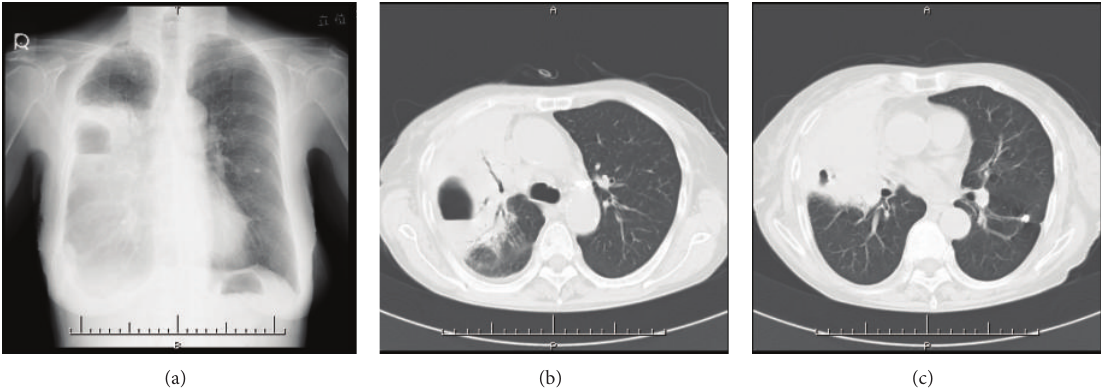
Figure 1: Chest X-ray (a) and CT ((b) and (c)) six years before the patient was referred to our hospital. CT revealed a lung abscess in the S2 field of the right lung and consolidation around this